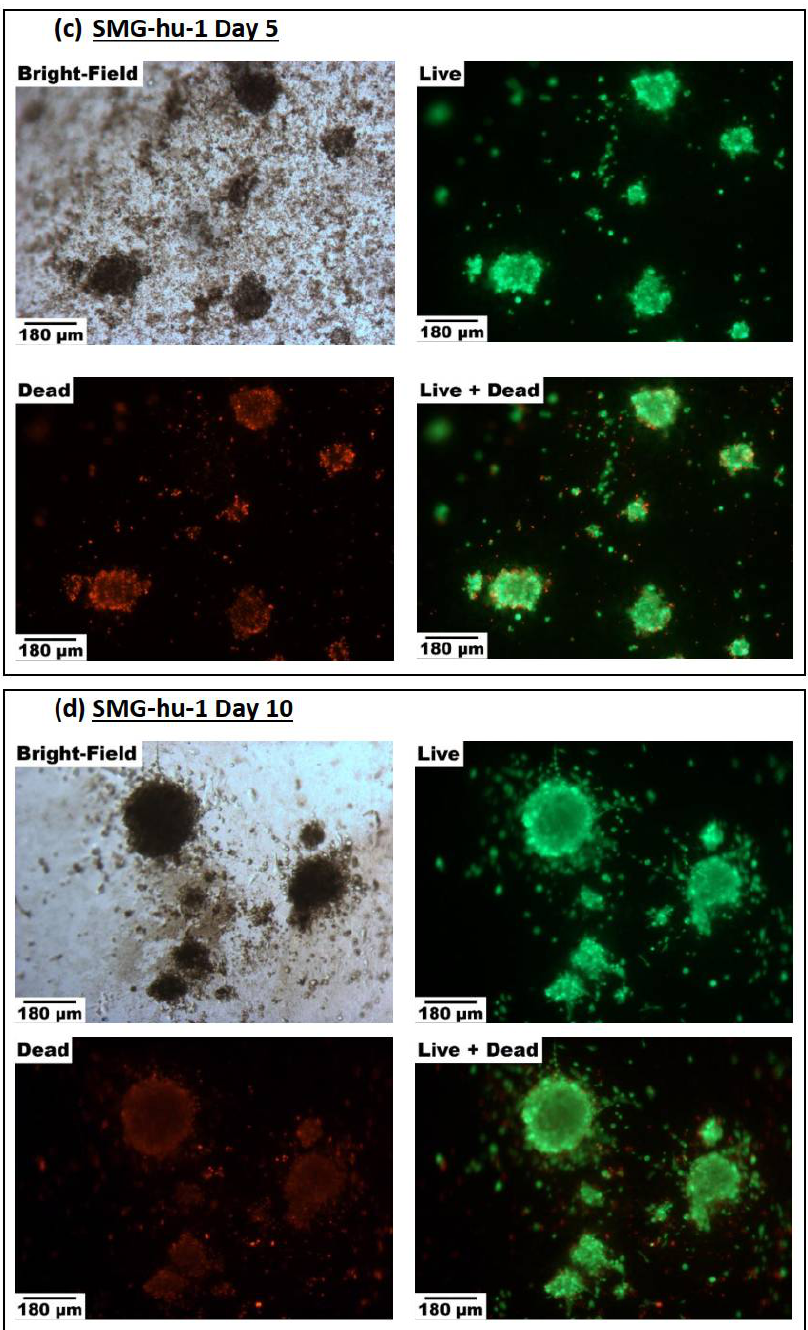
Figure 5. ( a – d ). Bright-light and Fluorescent Live–Dead images of salivary gland cells grown on EWA. Each figure ( a – d ) contains as set of images capturing either NS-SV-AC cells or SMG-hu-1 cells on day 5 or day 10, under bright-field light, fluorescent light with CalAM Live stain, fluorescent light with EthD Dead stain, and a combined superimposed image of the Live–Dead stained cells. ( a ) displays NS-SV-AC cells on day 5. ( b ) displays NS-SV-AC cells on day 10. ( c ) displays SMG-hu-1 cells on day 5. ( d ) displays SMG-hu-1 cells on day 5. Images were taken at 50× magnification; the scalebar on the bottom left corner represents 180 μm.